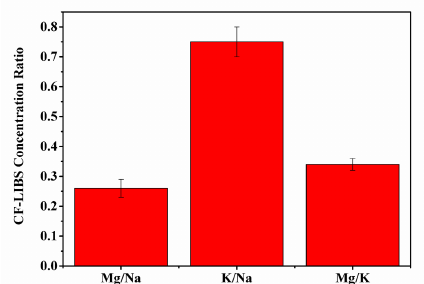
Figure 5. Concentration ratios of Mg/Na, K/Na, and Mg/K, evaluated with